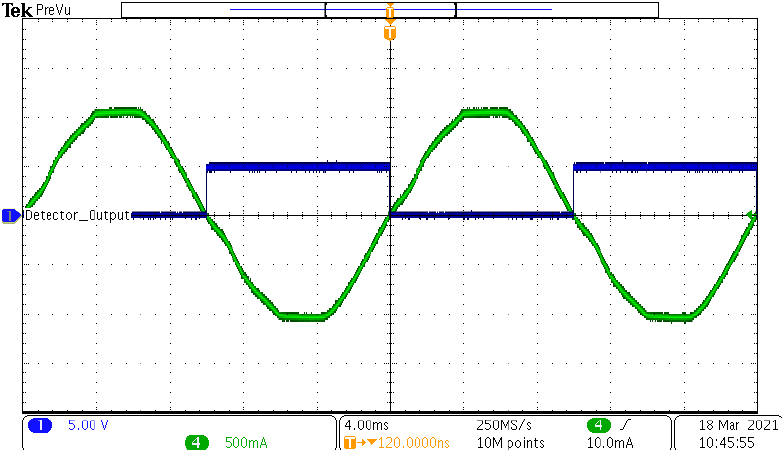
Figure 18. Current direction detection measurement (Blue, Current direction detector output 5 V/div; Green, Circuit current 500 mA/div).